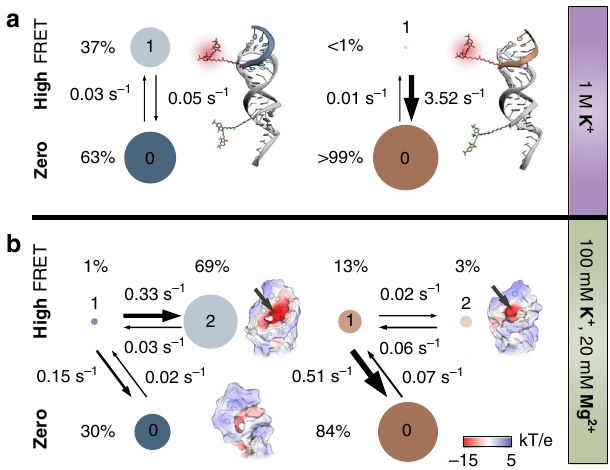
Fig. 3 Kinetic model of metal ion-induced IBS1* and dIBS1* recognition. a Two-state binding of IBS1* (blue) and dIBS1* (orange) to the EBS1* hairpin under high monovalent ionic strength (0: exon unbound; 1: exon bound). The area of the circle is proportional to the state population (speci fi ed in percentage) and the arrow width re fl ects the relative rate of the transition. Binding rates, k ′ on,01 , are indicated as pseudo- fi rst-order rates coef fi cients calculated from the trained HMM. b Three-state model with two degenerate high FRET states re fl ecting the coordination of Mg 2 + to the formed tertiary contact (0: exon unbound, Mg 2 + unbound; 1: exon bound, Mg 2 + unbound; 2: exon bound, Mg 2 + bound). Insets show surface representations of the RNA – RNA and RNA – DNA interaction, color coded by the electrostatic potential (red: − 15 kT e − 1 ; blue 5 kT e − 1 ). Arrows indicate coordination sites for Mg 2 + . Source data are provided as a Source Data fi